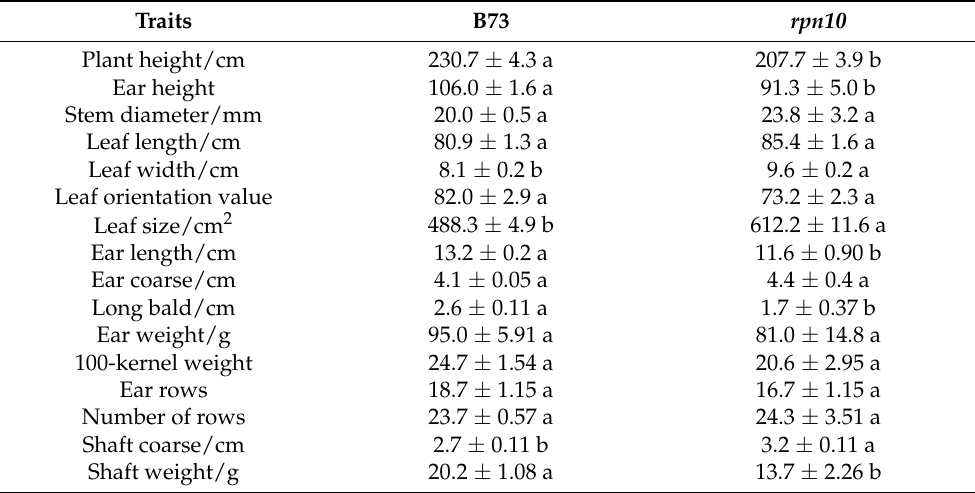
Table 1. The investigation on agronomic characters of B73 and rpn10